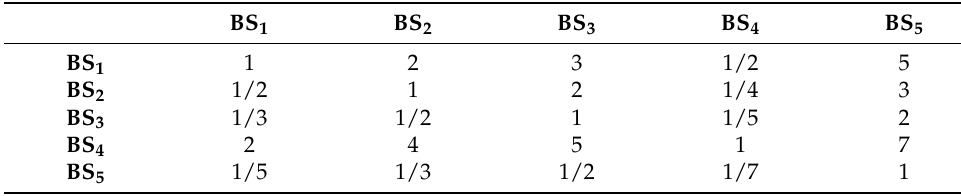
Table A8. The pairwise comparison matrix User _ C 1 .